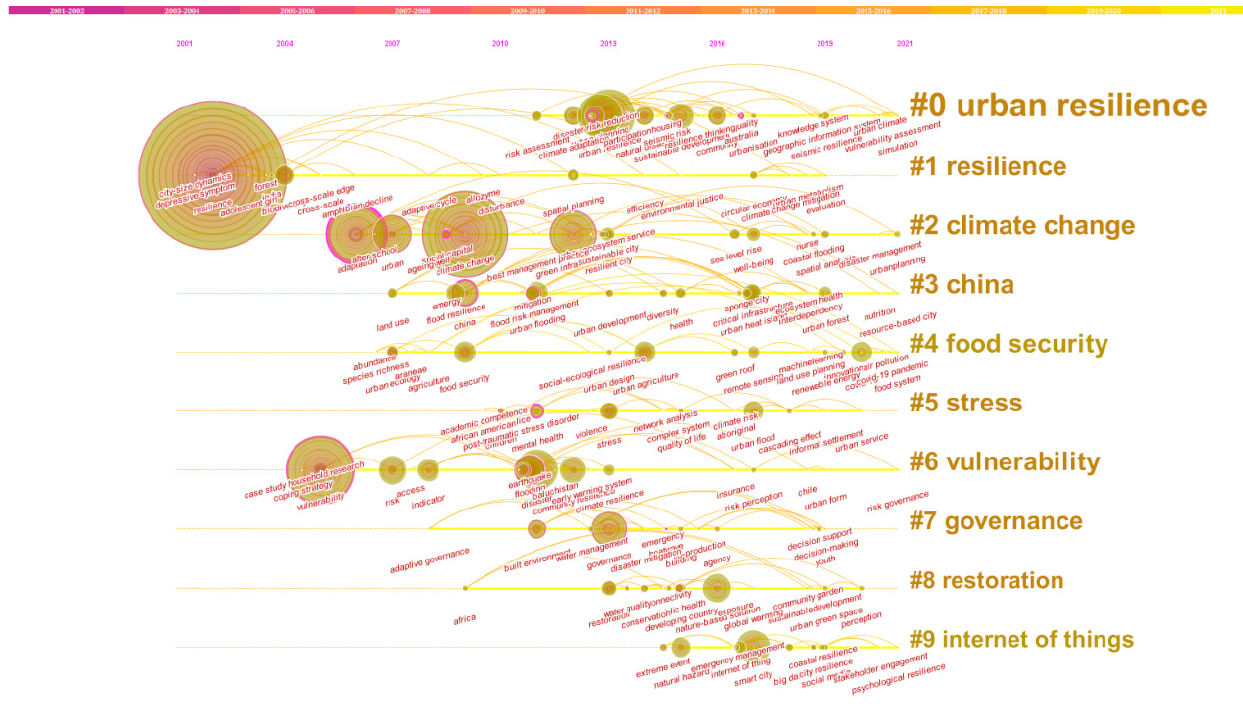
Figure 9. Temporal zoning map of RC keyword co-occurrence.